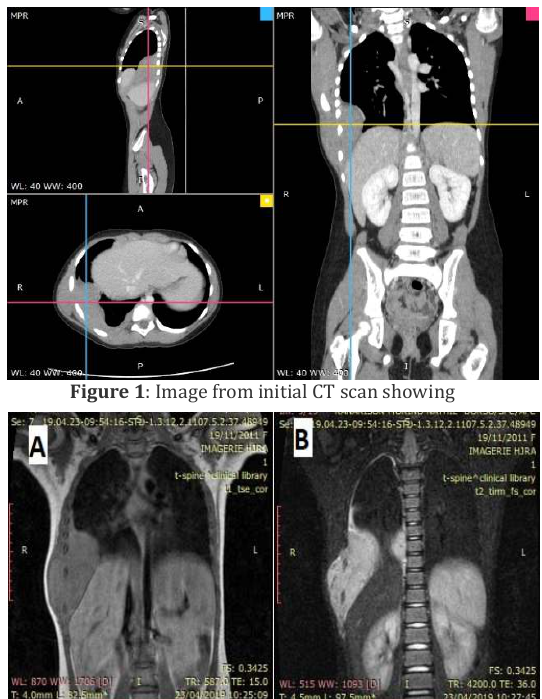
Figure 2: MRI revealed invasion of the anterior spinal cord and the intramedullary tumoral extension is located at T6 and T9 level.